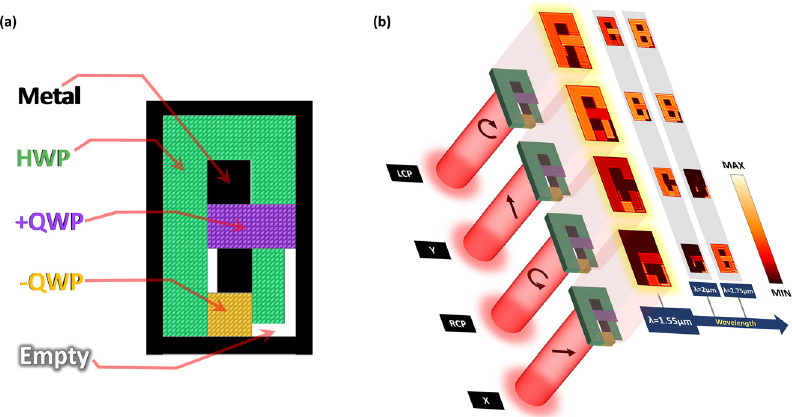
Figure 6: Four channels image storage for rapid polarization detection. (a) Schematic diagram of CNs arrangement for four input polarization states detection. (b) Simulated x -component fi eld distributions from four polarization states input at